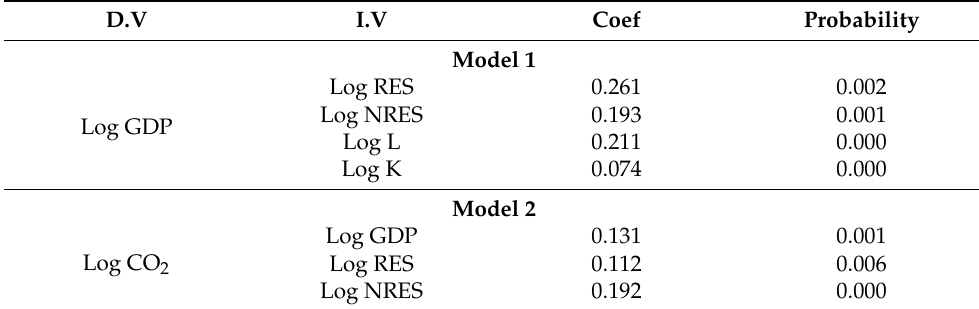
Table 4. DOLS test.